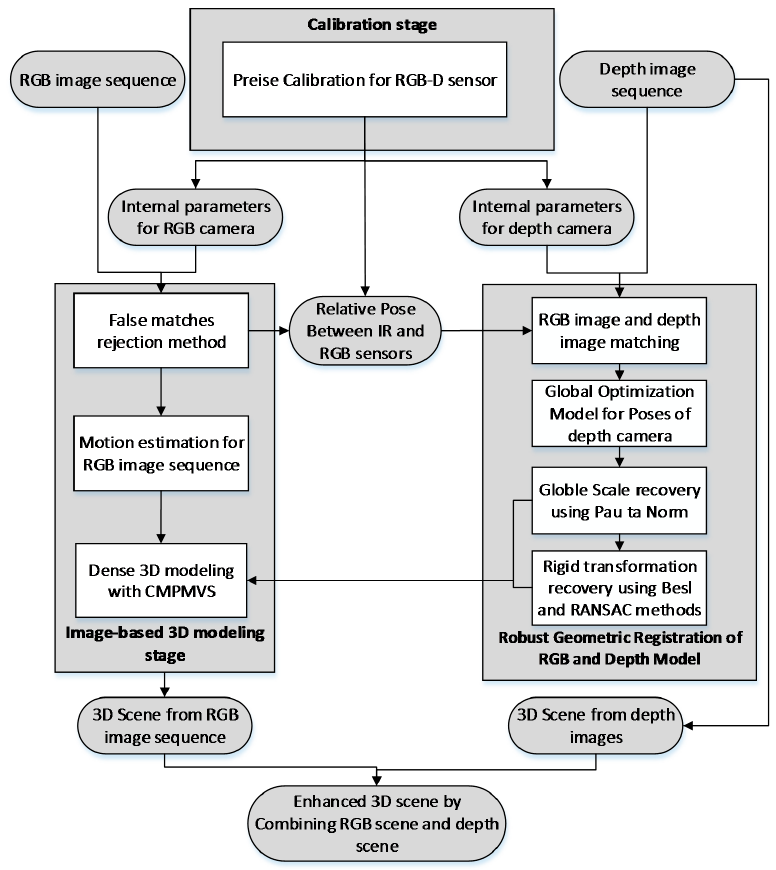
Figure 2. Flowchart of the enhanced RGB-D mapping approach.